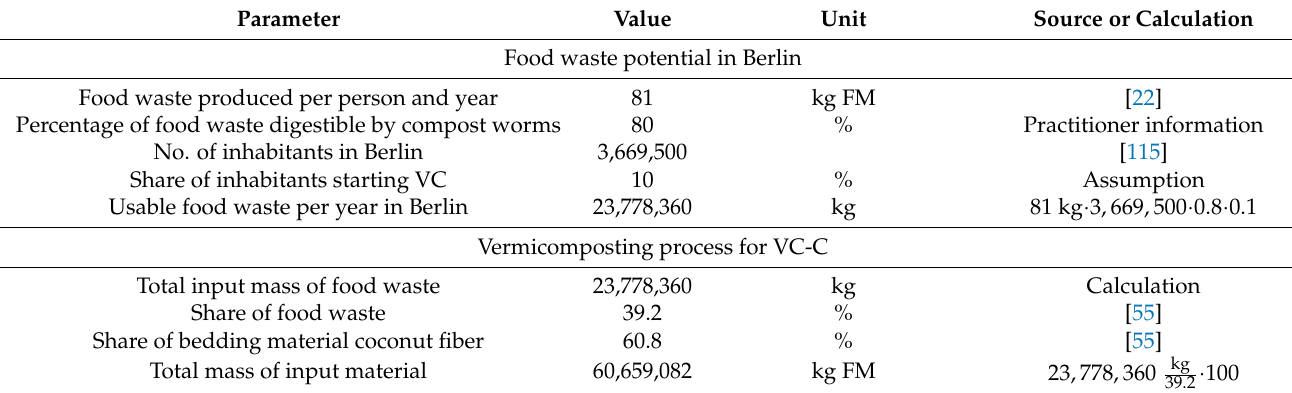
Table A4. Calculation of the P recycling potential for the VC-C vermicomposting process in the city of Berlin,